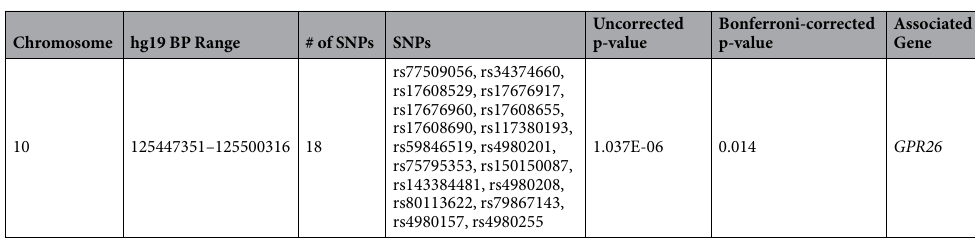
Chromosome hg19 BP Range # of SNPs SNPs